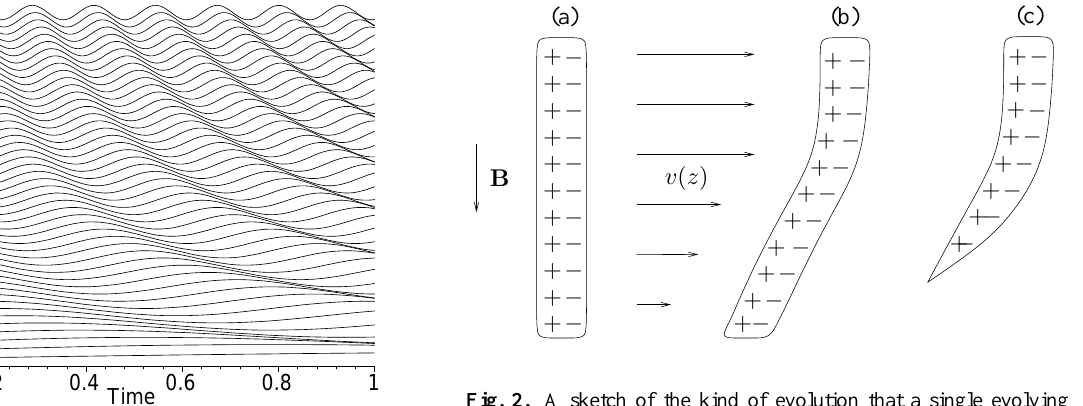
Fig. 2. A sketch of the kind of evolution that a single evolving structure (irregularity) would undergo in physical space if it were initially perfectly field-aligned. The vertical is along the magnetic field and the electron E × B drift direction is to the